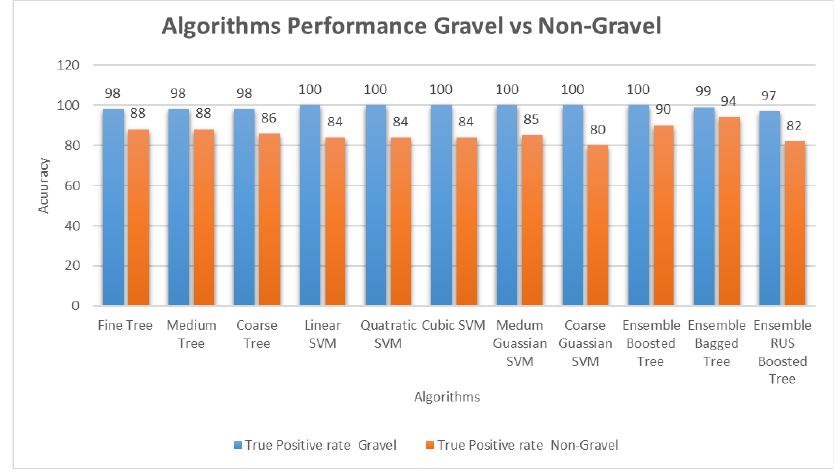
Figure 7. Classification performance of the classical algorithm. The figure shows the true pos-